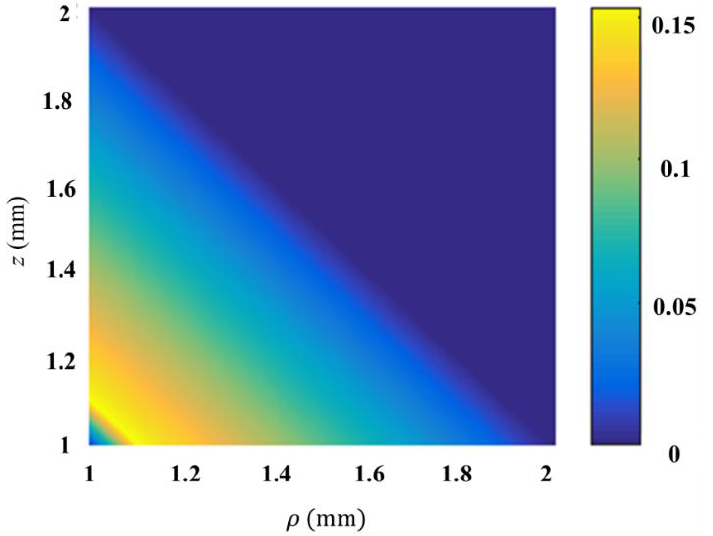
Figure 6. Top view of the enrichment function diagram of chosen element E based on triangular elements.